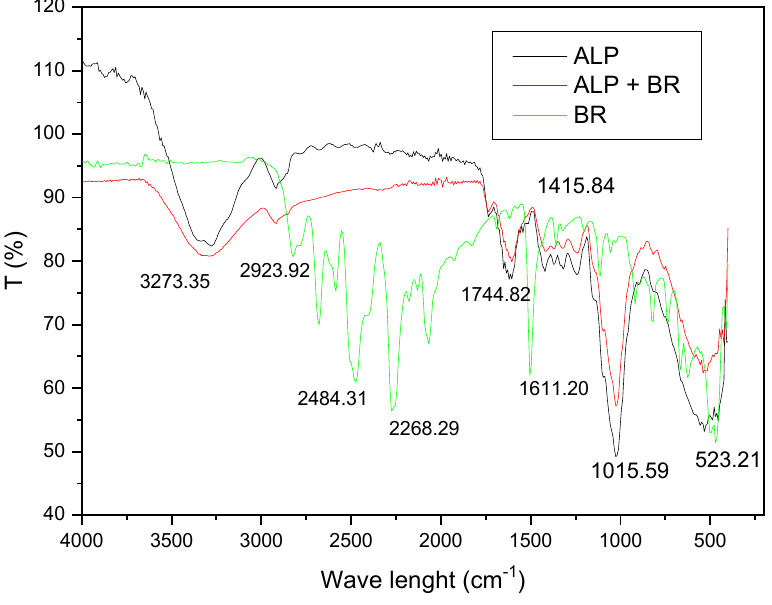
Figure 1. FTIR spectra of BR, ALP and ALP + BR.